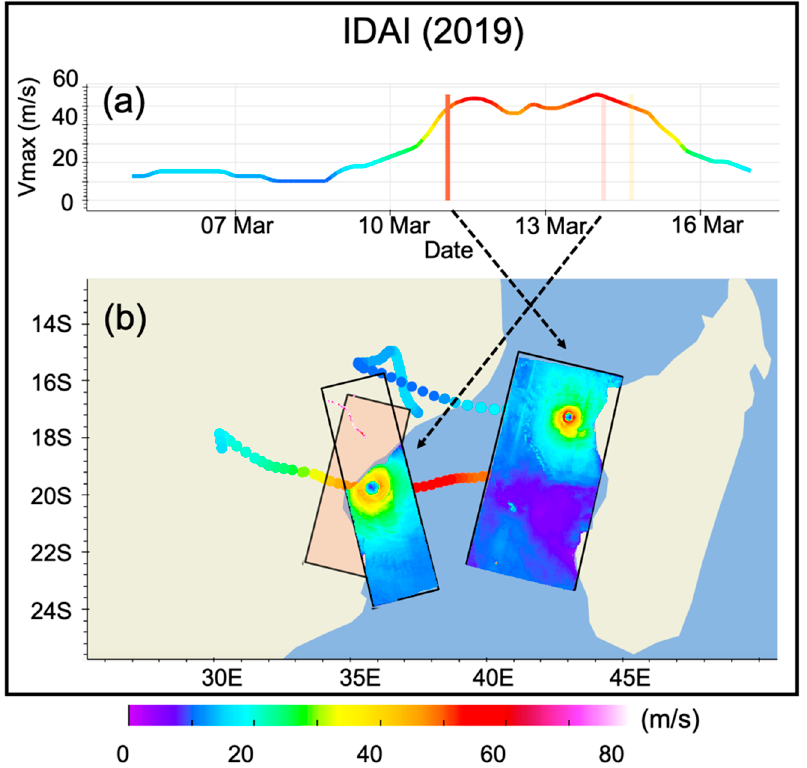
Figure 25. As in Figure 24, but for ( a ) TC IDAÏand ( b )SAR images collected by S1A on 11 (02:43 UTC) and 14 (03:08 UTC) March 2019.